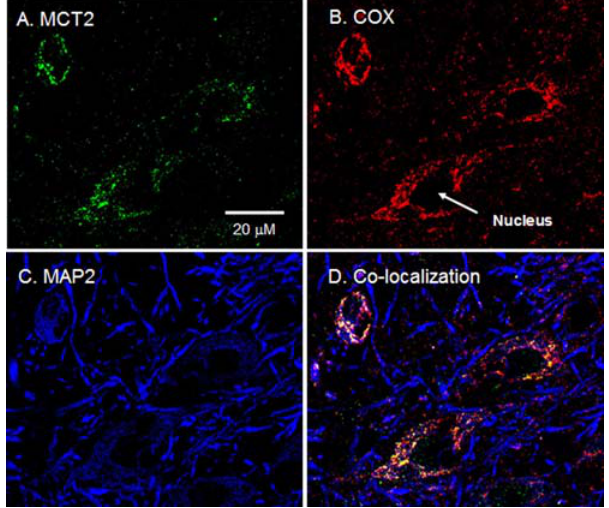
Figure 2. Immunohistochemical images of rat brain cross- sections demonstrating mitochondrial MCT2 in thalamic neurons. When signals from probes for MCT2 (A, green), and mitochondrial COX (B, red) were merged with those of the neuronal marker MAP2 (C, blue), superposition of the signals (D, yellow/white) showed colocalization of MCT2 and components of the mitochondrial reticulum in neurons (white arrows). Scale bar=20 m m.